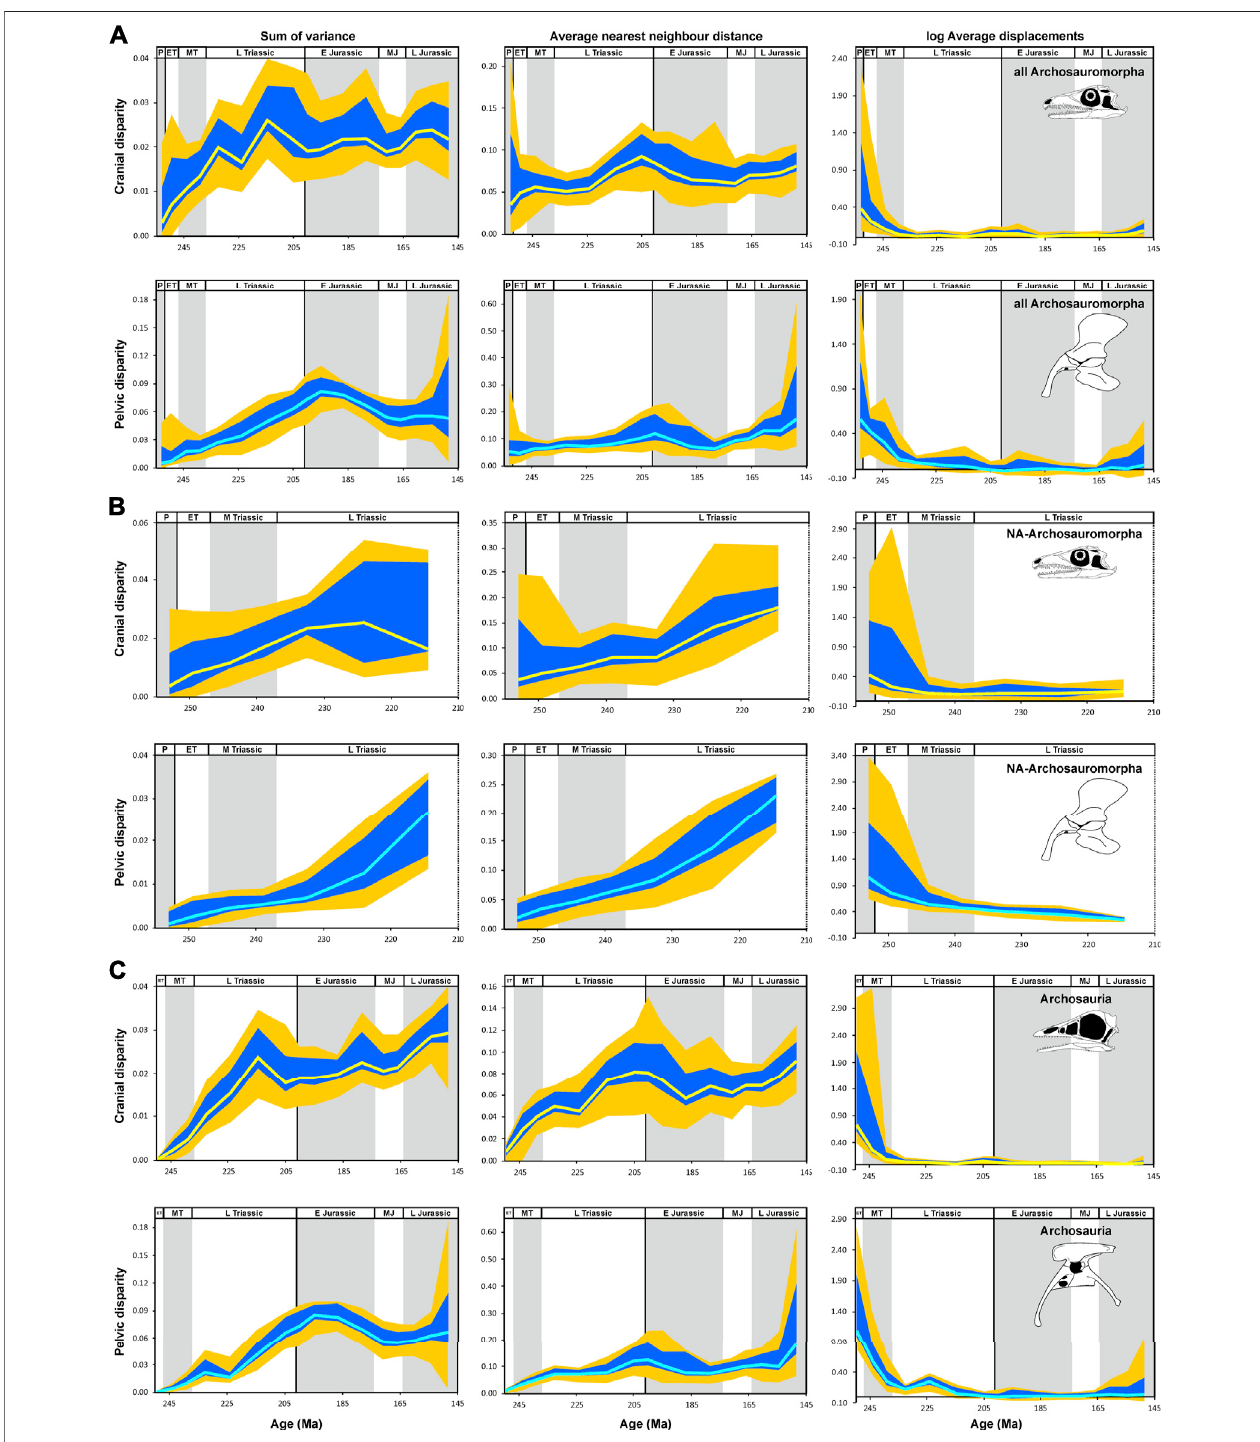
FIGURE 6 | Temporal disparity of archosauromorph cranium and pelvis captured by 2D geometric morphometrics from the late Permian to the Late Jurassic, as measured from phylogenetically interpolated values ( “ gradualistic ” model), with disparity quanti fi ed as the sum of variances, average nearest neighbor distance and average displacements (log-transformed) based on shape variables of the principal component analysis. (A) Cranial and pelvic disparity of all archosauromorphs. (B) Cranial and pelvic disparity of non-archosaurian archosauromorphs (stem-archosaurs). (C) Cranial and pelvic disparity of crown-archosaurs. The yellow (cranium) and cyan (pelvis) solid lines show the median of estimated disparity for each bin, with the orange bands showing the total range of disparity estimated from 1,000 time- calibrated trees and the blue band showing the range delimited by the 2.5 and 97.5% quantiles of the same. Prolacerta skull (A,B) modi fi ed after Ezcurra (2016); Archaeopteryx skull (C) modi fi ed after Rauhut (2014); Coelophysis pelvis (C) modi fi ed after Tykoski (2005). Abbreviations: P, Permian; ET, Early Triassic; MT Middle Triassic L Triassic, Late Triassic; E Jurassic, Early Jurassic; MJ, Middle Jurassic; L Jurassic, Late Jurassic ( Supplementary Material S1-Tables S4 – S6 ).